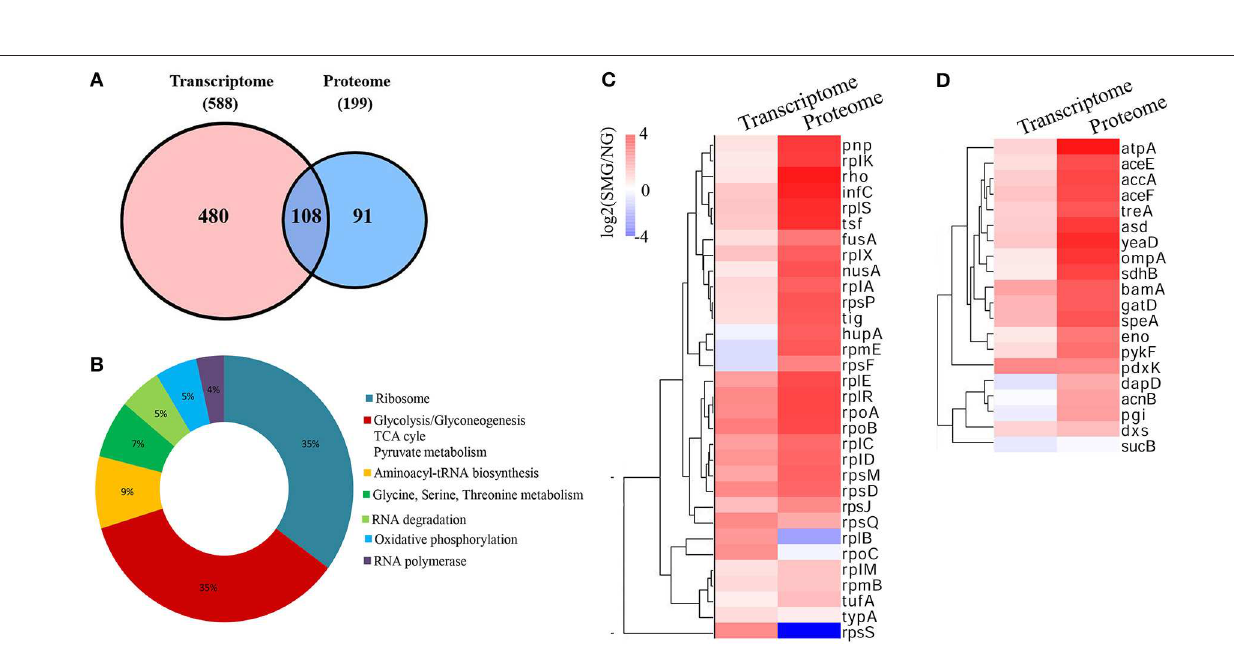
Frontiers in Bioengineering and Biotechnology | www.frontiersin.org